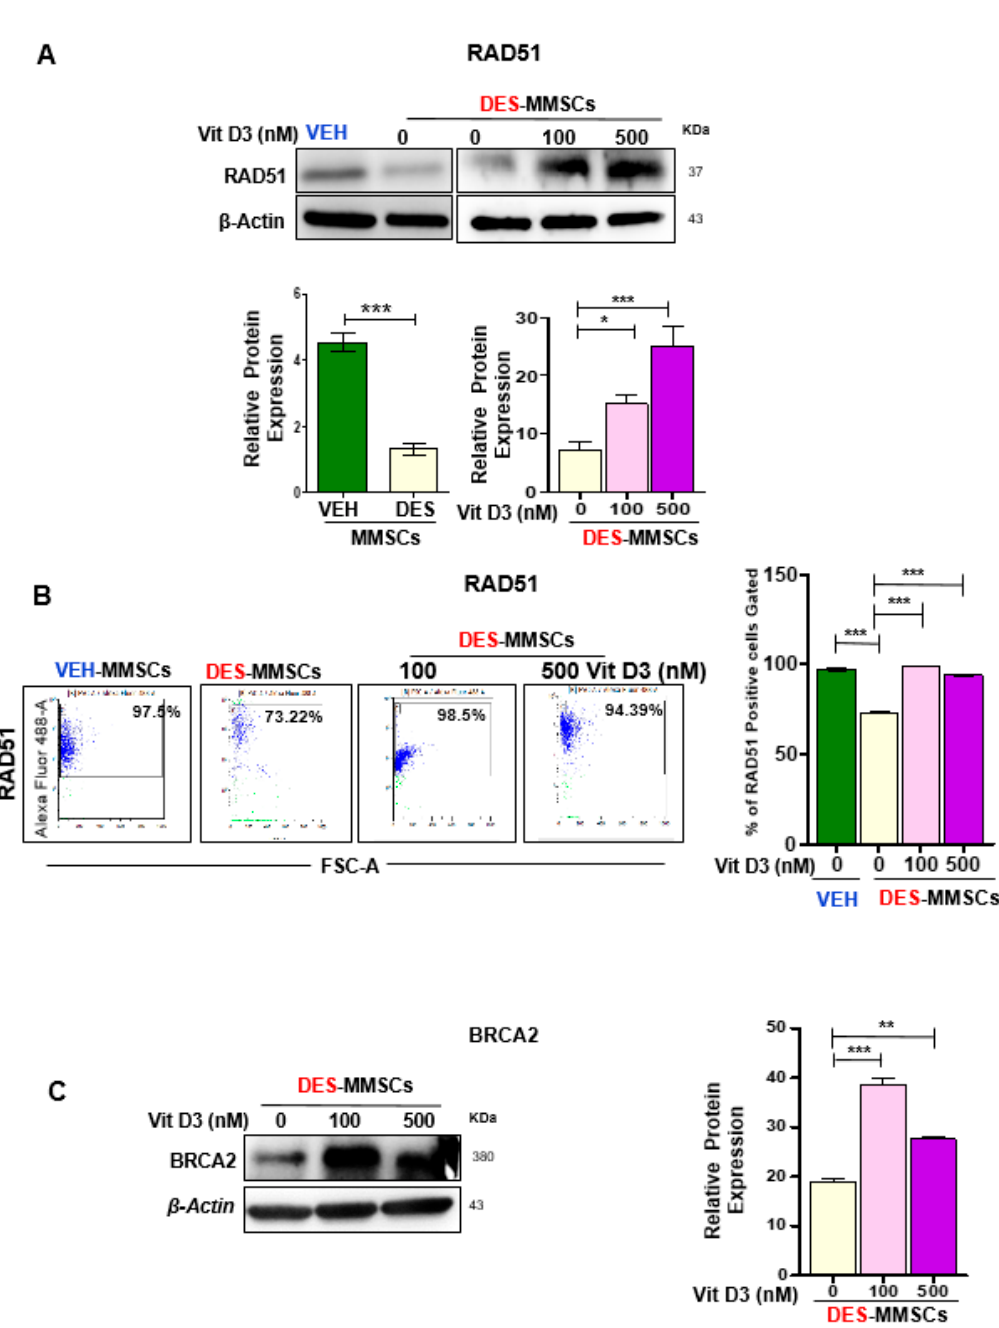
Figure 4. The effect of VitD3 treatment on the expression of DNA repair effectors in DES-MMSCs. Protein lysates were prepared from untreated VEH-MMSCs as well as DES-MMSCs in the presence or absence of VitD3 treatment. ( A ) Western blot analysis was performed to determine the protein levels of RAD51 (top panel). The intensity of each band was quantified and normalized to the corresponding β -actin; relative values were used to generate the data graph as mean ± SD (bottom panel). ( B ) Flow cytometry analysis of RAD51 was performed in untreated VEH-MMSCs as well as DES-MMSCs in the presence or absence of VitD3 treatment (left panel). Data are represented as mean fluorescence intensity after intracellular staining of RAD51 (right panel). ( C ) Western blots measured the protein levels of BRCA2 after the treatment of DES-MMSCs with VitD3 (left panel). Quantitative analysis of BRAC2 was performed using Image J (right panel). Mean ± SD values were used to build the data graph, with * p < 0.05, ** p < 0.01, and *** p <